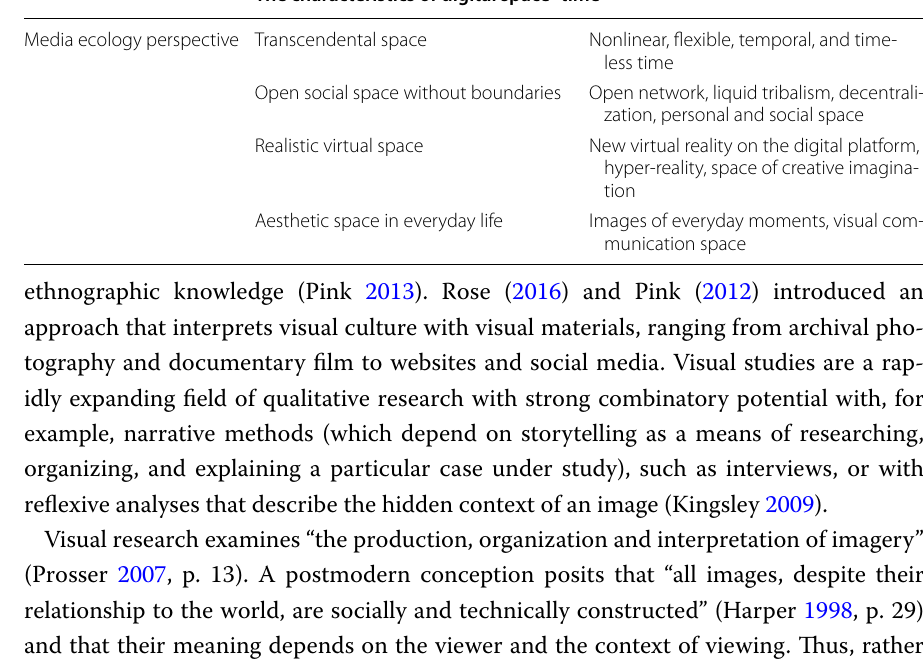
Table 1 Characteristics of digital space–time from the perspective of media ecology The characteristics of digital